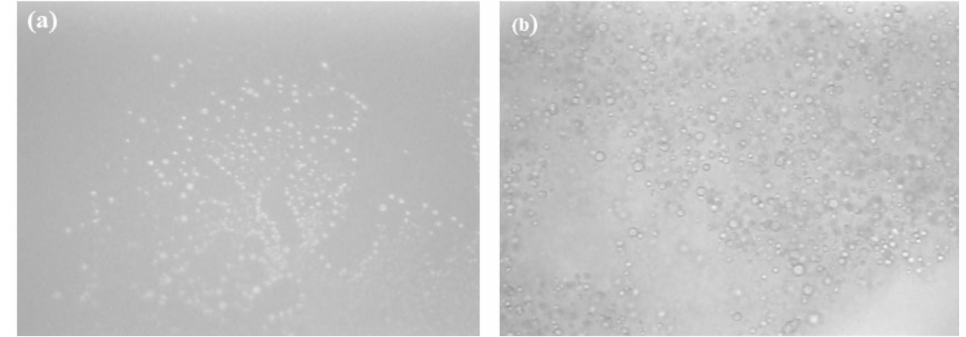
Figure 3. Microscopic laser images of Pickering emulsions for ( a ) run 1 and ( b ) run